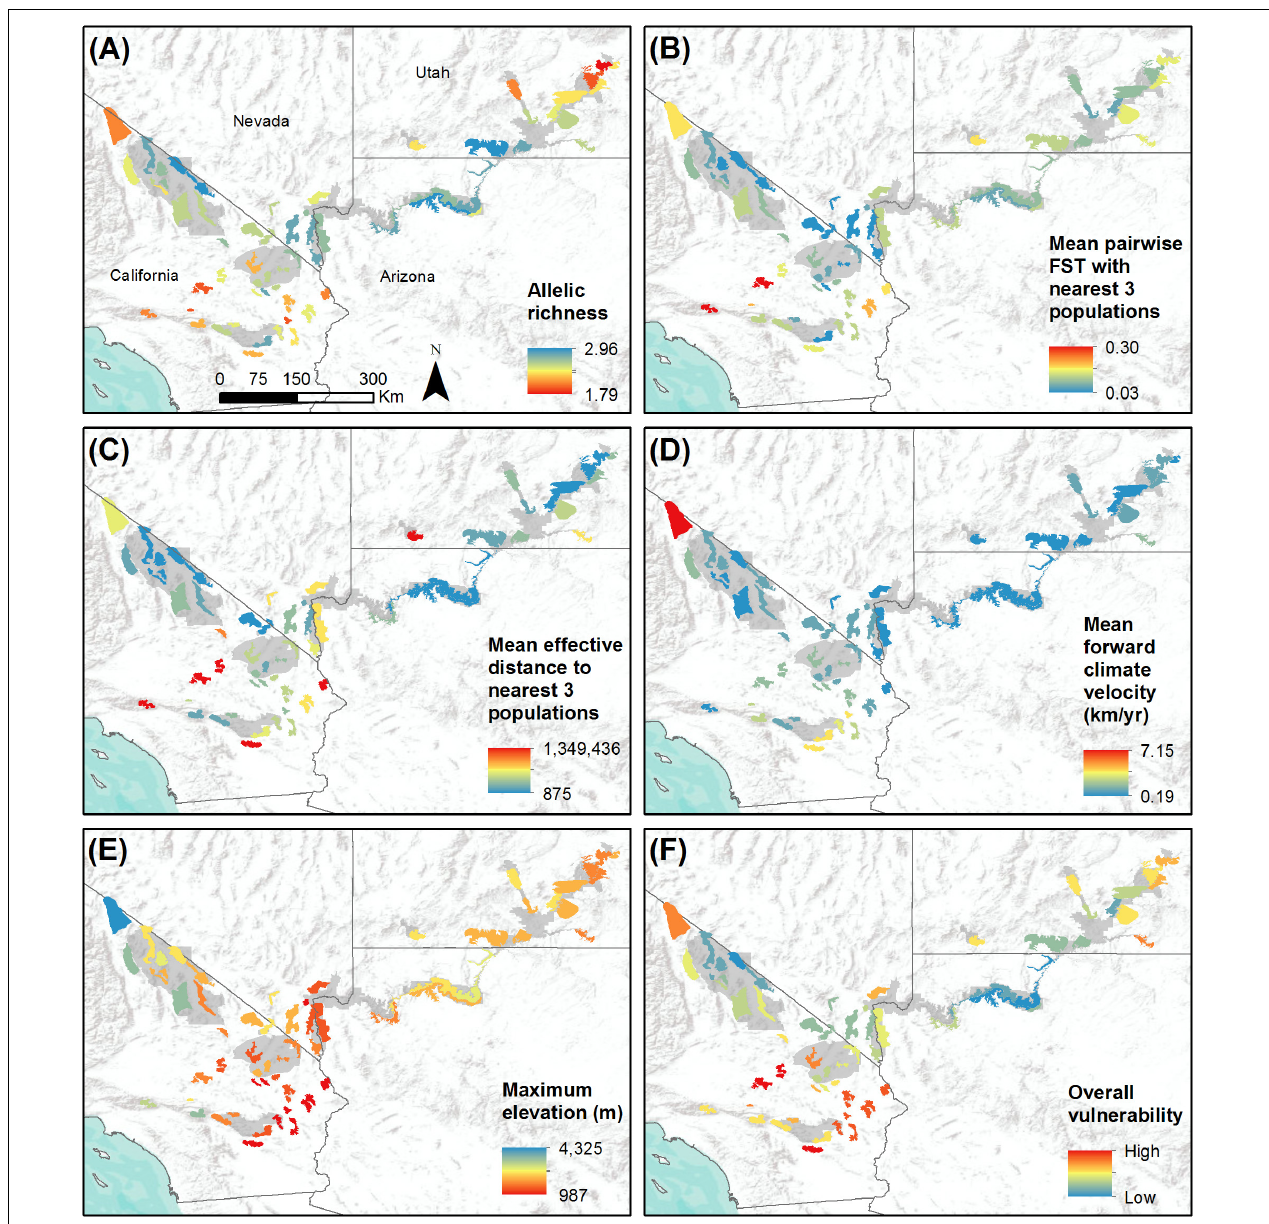
FIGURE 4 | Study-wide comparison of populations with respect to variables that may influence population vulnerability to climate change. Populations are shown with colored polygons. National Park Service units are shaded gray. (A) Genetic diversity, measured as allelic richness. (B) Genetic isolation, measured as mean pairwise F ST with three nearest populations. (C) Geographic isolation, measured as effective distance to three nearest populations. (D) Mean forward climate velocity for RCP4.5 emissions scenario. (E) Maximum elevation in meters. (F) Overall vulnerability, measured as mean percentile across variables (A–E) . For all variables, red polygons indicate highest vulnerability and blue polygons indicate lowest